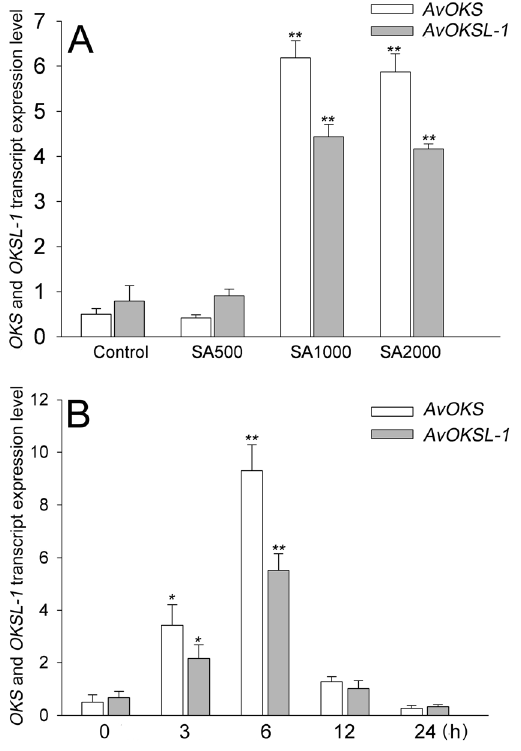
Figure 6. Effect of SA elicitation on transcript accumulation of OKS and OKSL-1 . (A) Transcript accumulation of OKS and OKSL-1 at 6 h of 0, 500, 1000, and 2000 m M SA treatment relative to that of Ubiquitin . (B) Time course analysis of gene expression of OKS and OKSL-1 in the presence of 1000 m M SA relative to that of Ubiquitin . Each value is the mean of replicates and error bars mean standard deviation. Statistical analysis was carried out using the Tukey test (* p , 0.05, ** p , 0.01). Asterisks indicate significant differences compared to control